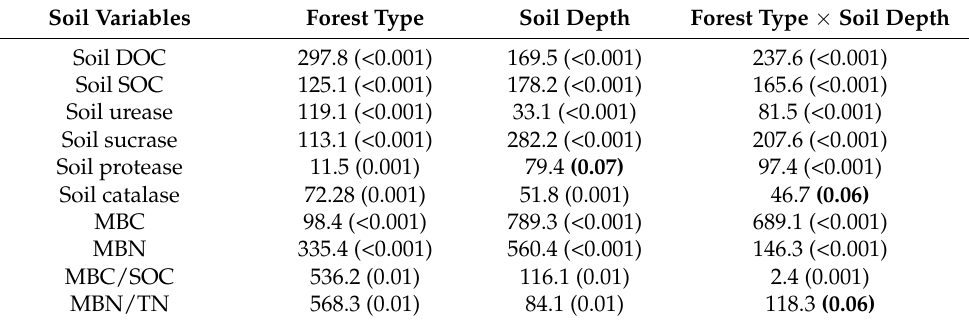
Table 2. Two-way ANOVA results for the effects of forest type, soil depth, and forest type × soil depth at p < 0.05, p < 0.01, and p < 0.001 significant level.